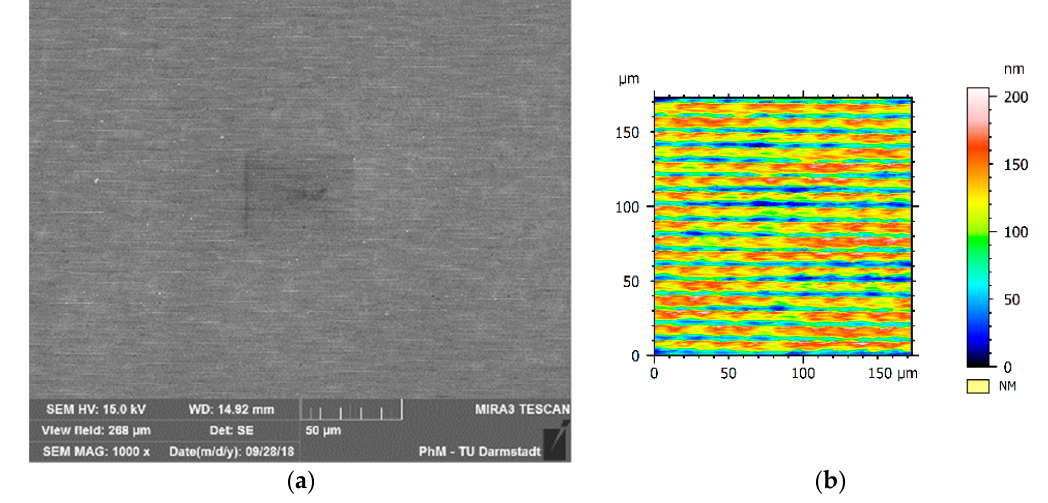
Figure 10. SEM ( a ) and CLSM ( b ) picture of the sample surface.